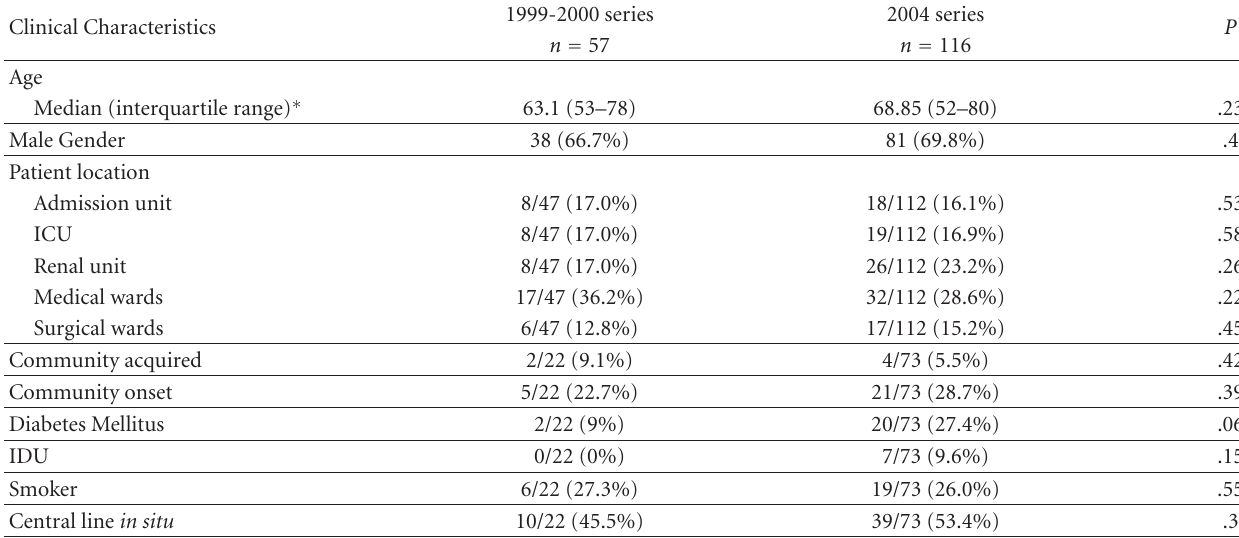
Table 2: Comparison of clinical characteristics of S. aureus bacteraemia cases identified retrospectively from 1999-2000 and 2004. Completely evaluable case notes were available for 22 and 73 cases,